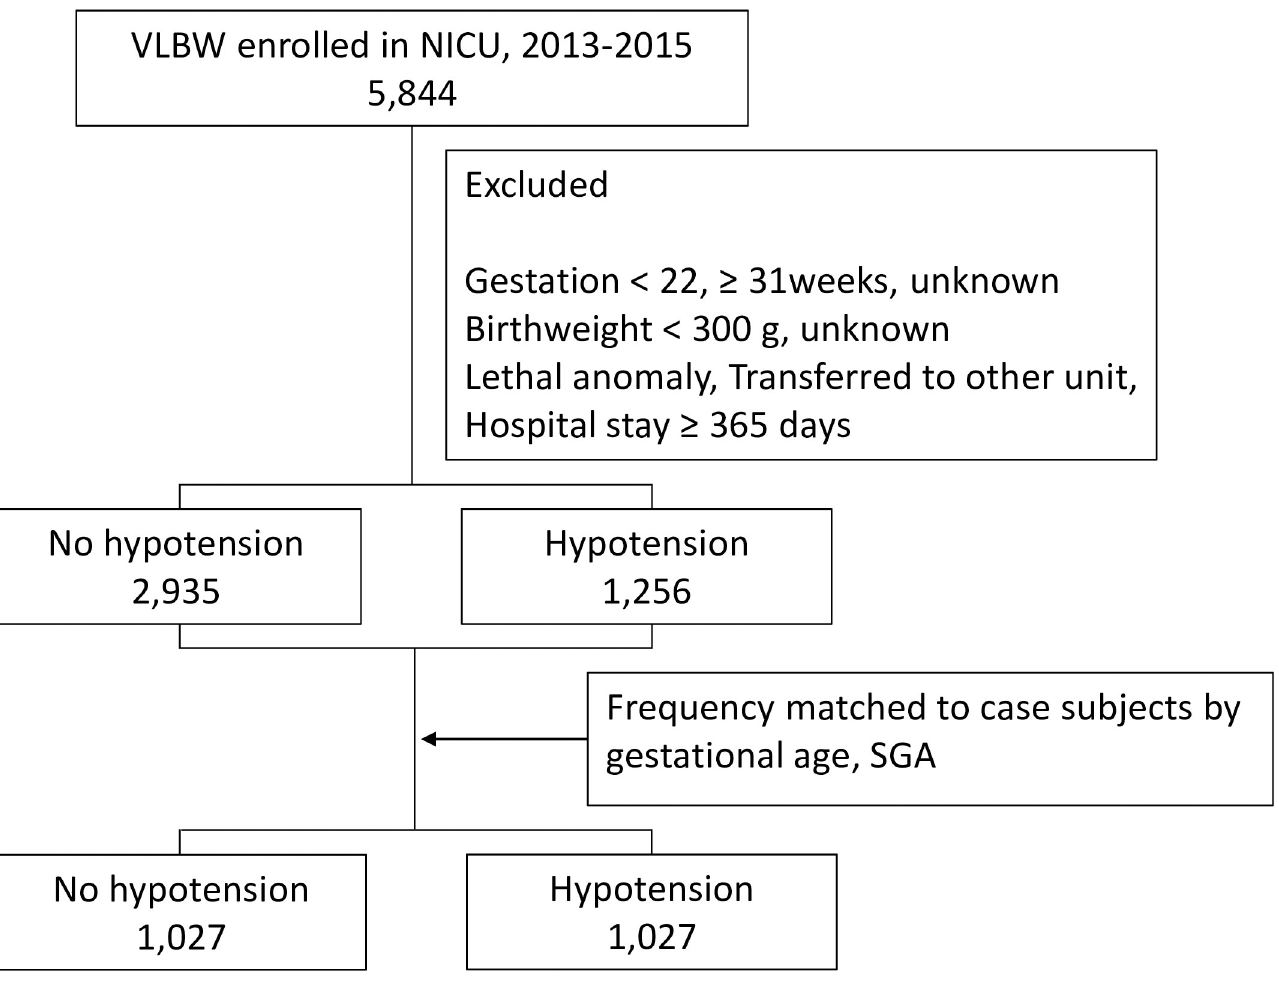
Fig 1. Flow-chart identifying the study